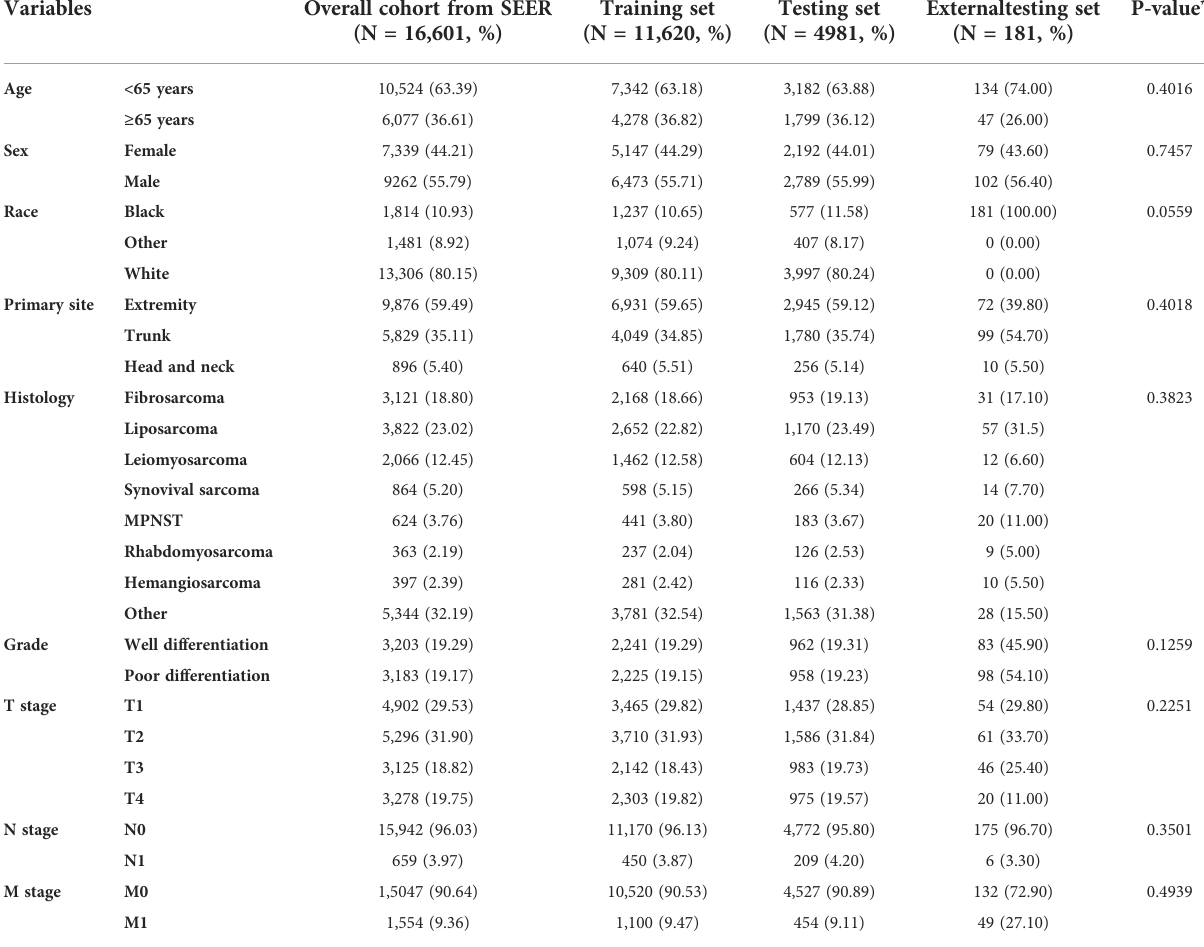
TABLE 1 The demographic and clinicopathological characteristics of patients with soft tissue sarcoma with or without lymph node metastasis.